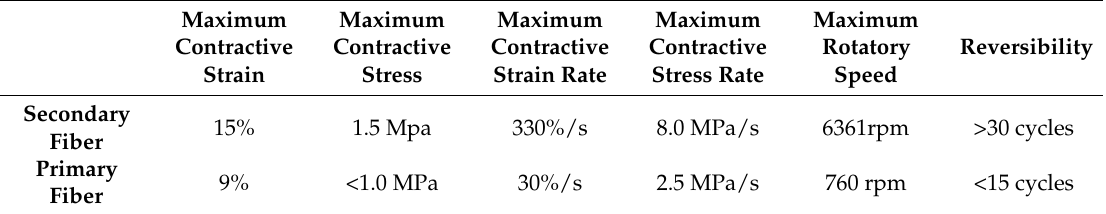
Table 2. Performance of a hierarchical CNT fiber (composed of 20 primary fibers) and a primary CNT fiber (composed of 20 CNT sheets) when exposed to dichloromethane [113].